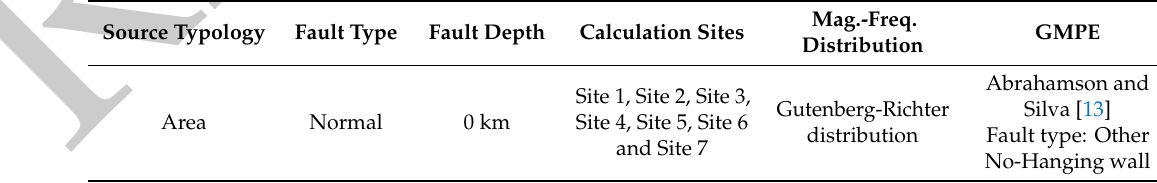
Table 3. Area source-based test case